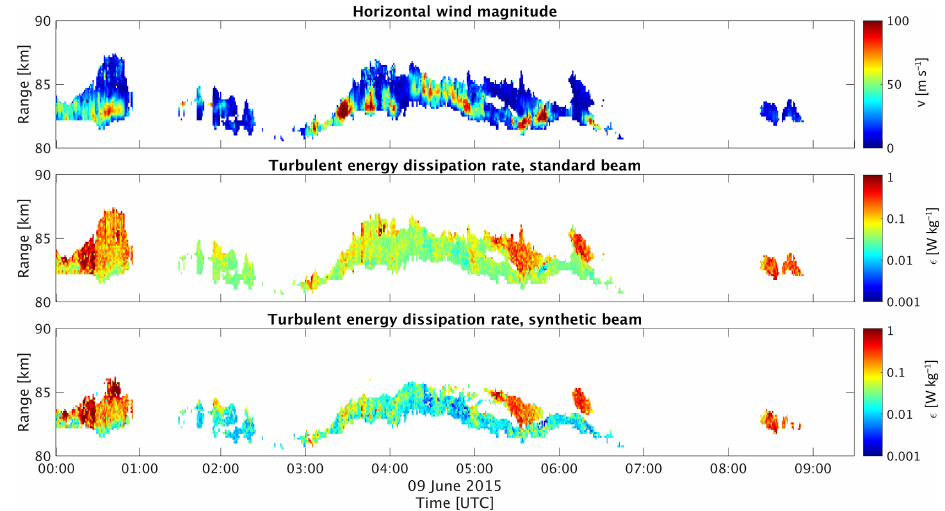
Figure 8. Top: magnitude of the horizontal wind velocity derived by DBS from Doppler velocity maps. Middle: derived energy dissipation rate for the standard narrow beam. Bottom: derived turbulent energy dissipation rate for a synthetic narrow